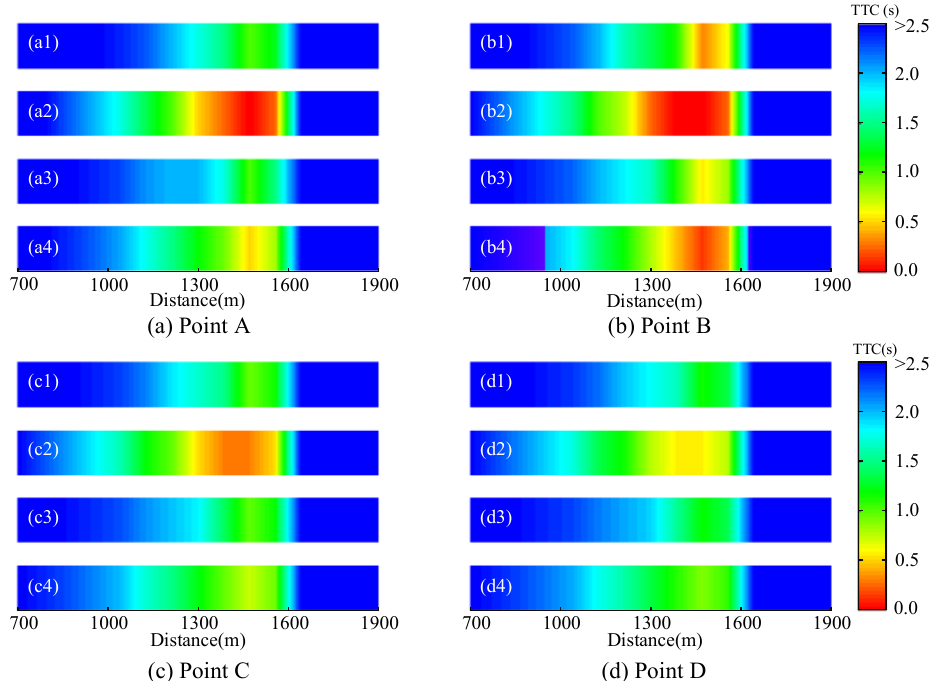
Figure 12. Average TTC values in different lanes. ( a1 )–( d1 ) denote median lane, ( a2 )–( d2 ) denote center lane, ( a3 )–( d3 ) denote shoulder lane and ( a4 )–( d4 ) denote mainline section.